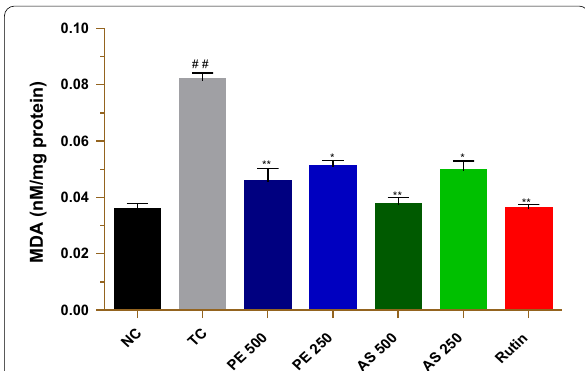
toxic = P. erinaceus and = 30 mM glucose; + 30 mM glucose. The +